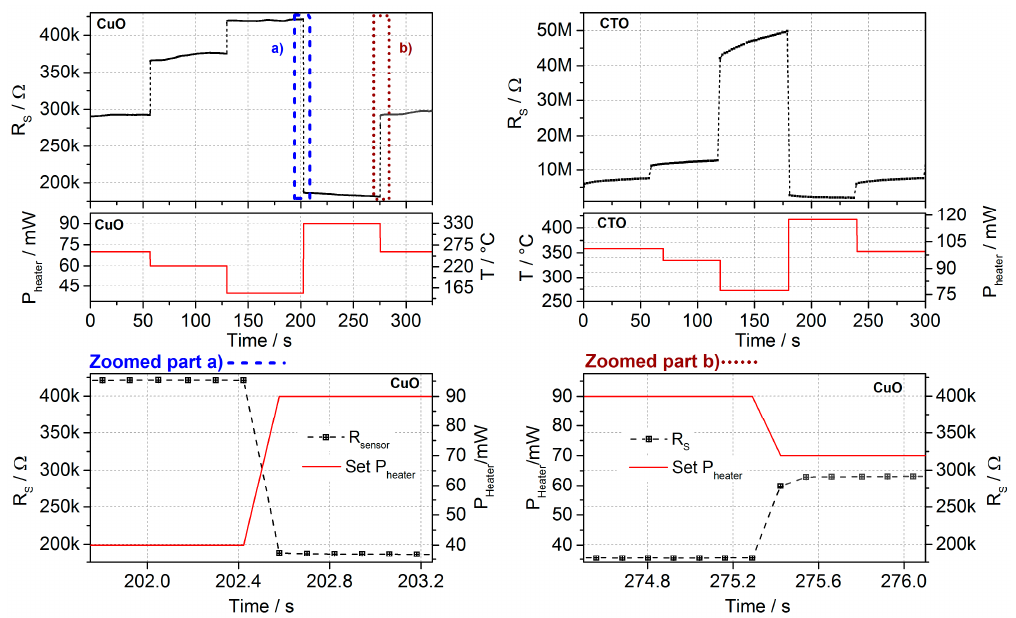
Figure 6. ( Top ) Evolution of the layer’s resistivity at different driving temperatures, which are associated with the heating power consumption of the chip. ( Bottom ) Part a) and b) show a more detailed view of the resistivity evolution after a temperature step. It demonstrates that the new steady-state is achieved in less than 250 ms, for both, temperature rises and drops.